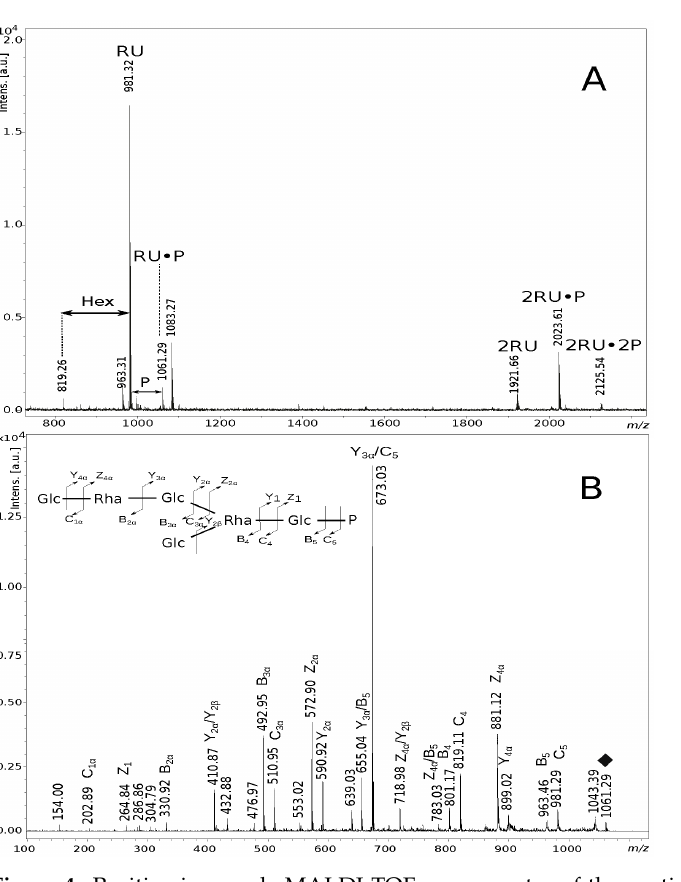
Table 2. Interpretation of positive ion mode MALDI-TOF mass spectra of the partially hydrolysed EPS (Figure 4A) and the MS/MS fragmentation of the hexasaccharide represented by the ion at m / z 1061.29 (inset structure) (Figure 4B).